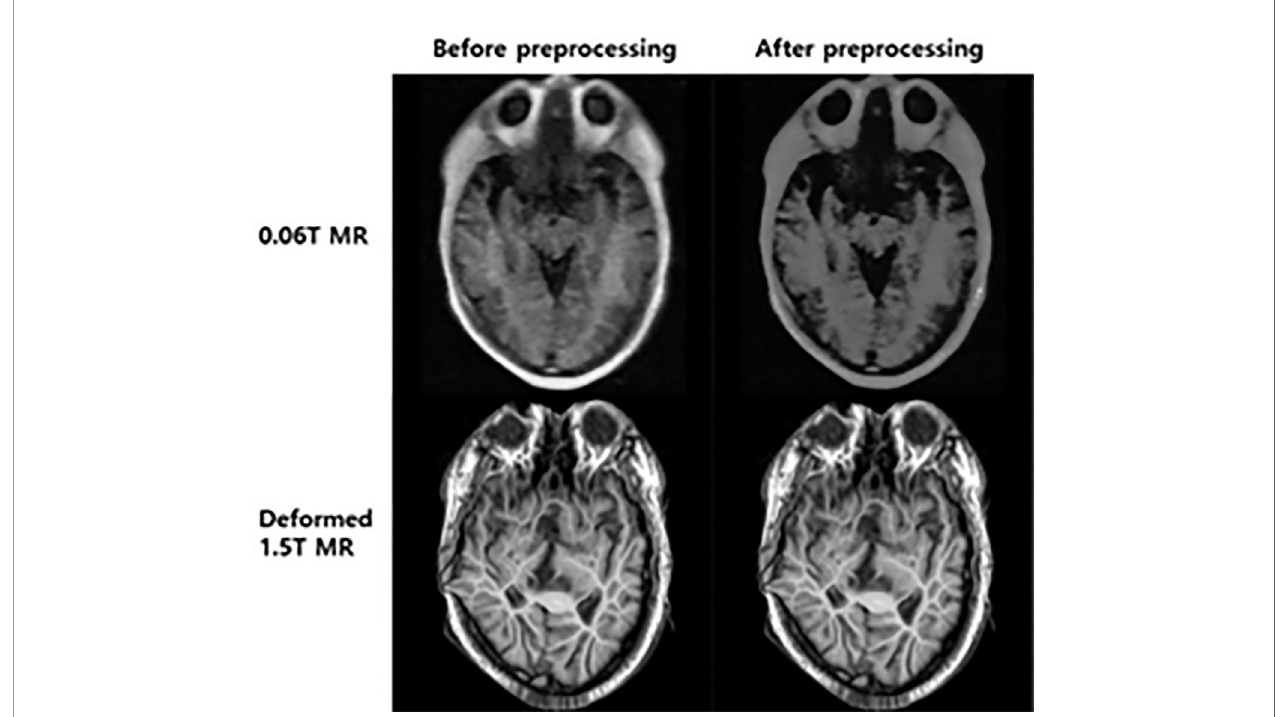
FIGURE 3 | Reduced intensity after preprocessing of MR images (Han ’ s